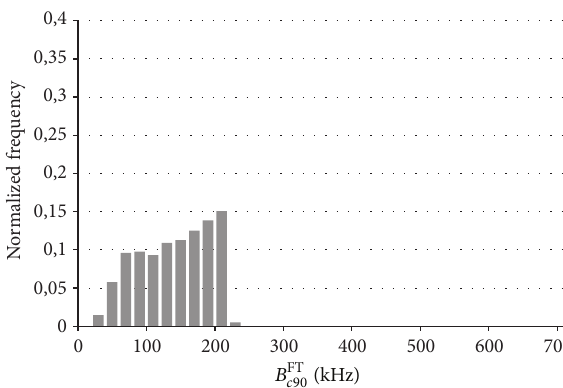
Figure 13: Histogram of coherence bandwidth values estimated from rms delay spread for correlation level 0.9 in the Gdansk city area.